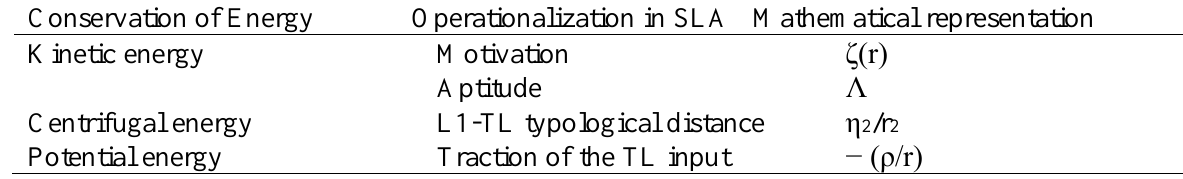
Operationalization of Central Force Energies in